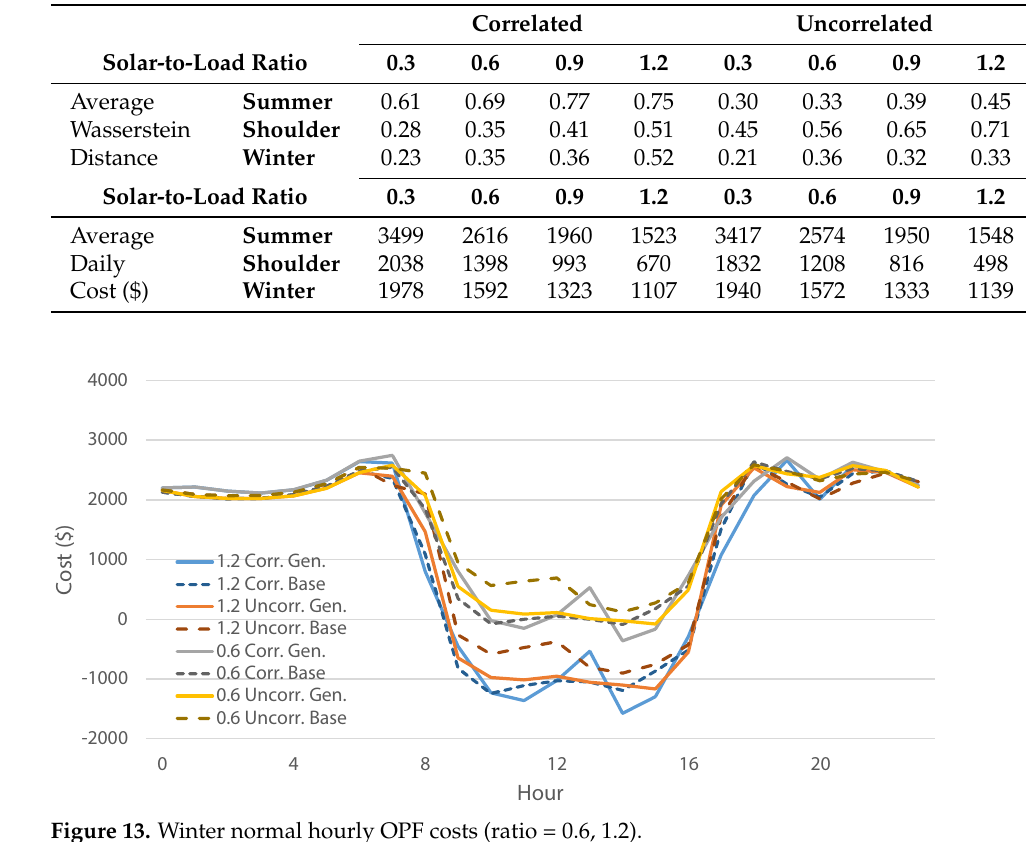
Table 4. Results summary for normal conditions.